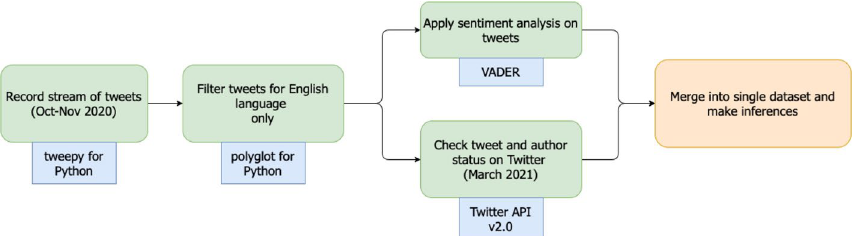
Fig. 3 Flowchart of steps used in this study. The tool/package used for each step is added in the accompanying blue rectangle